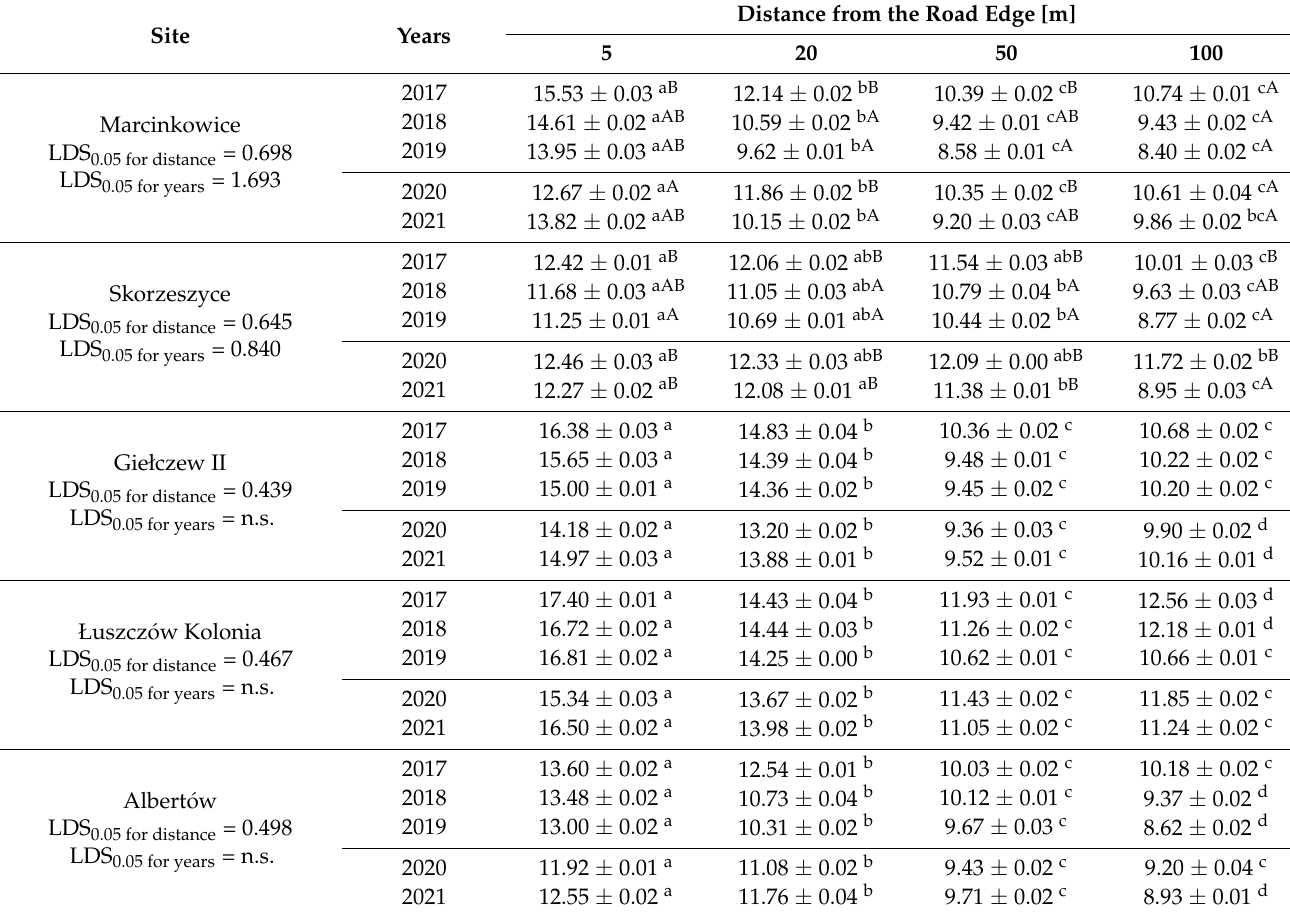
Explanation: a–d —different letters indicate significant difference at p ≤ 0.05 (LDS for distance from the road edge); A,B —different letters indicate significant difference at p ≤ 0.05 (LDS for years 2017–2021); n.s.—not significant at p ≤